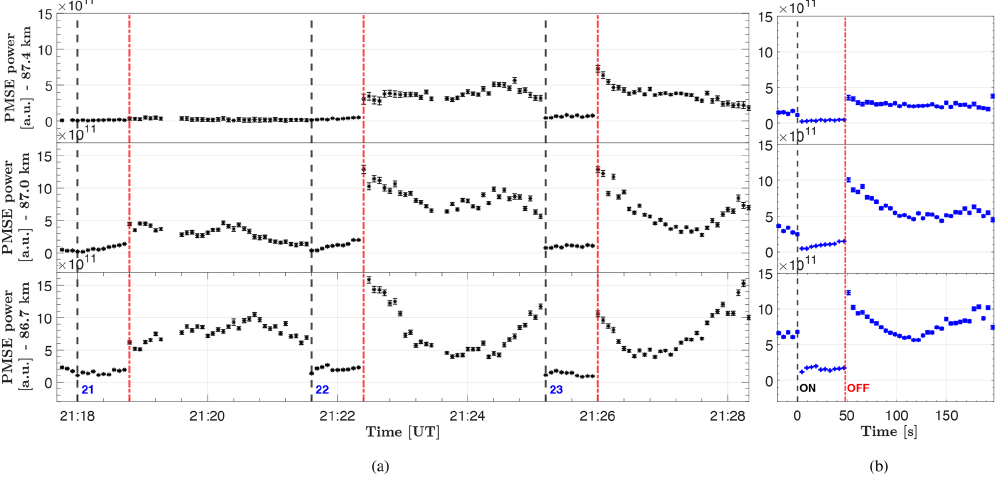
Figure 15. Individual overshoot curves (a) from intervals B and C (from Fig. 13) shown with their corresponding altitude average on the right-hand side (b) . Heating cycle numbers are shown at the bottom, and the on-and-off period for the averaged cycles is also